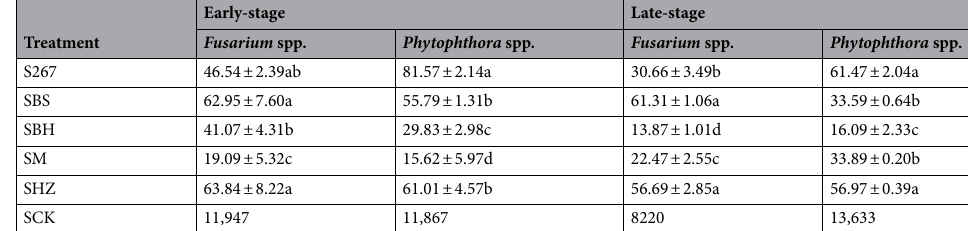
Table 1. Average number of Fusarium spp. and Phytophthora spp. in soil, and the percent relative efficacy of biofertilizers in the early and late stages of cucumber growth. Means (N = 3) within the same time period accompanied by the same letter are not statistically different (P = 0.05), according to Duncan’s new Multiple- Range test. S267 = Trichoderma Strain 2 67 added to soil; SBH = Bacillus subtilis and T. harzianum biofertilizers added to soil; SBS = B. subtilis biofertilizer added to the soil; SM = Compound biofertilizer added to soil; and SHZ = T. harzianum biofertilizer added to soil.